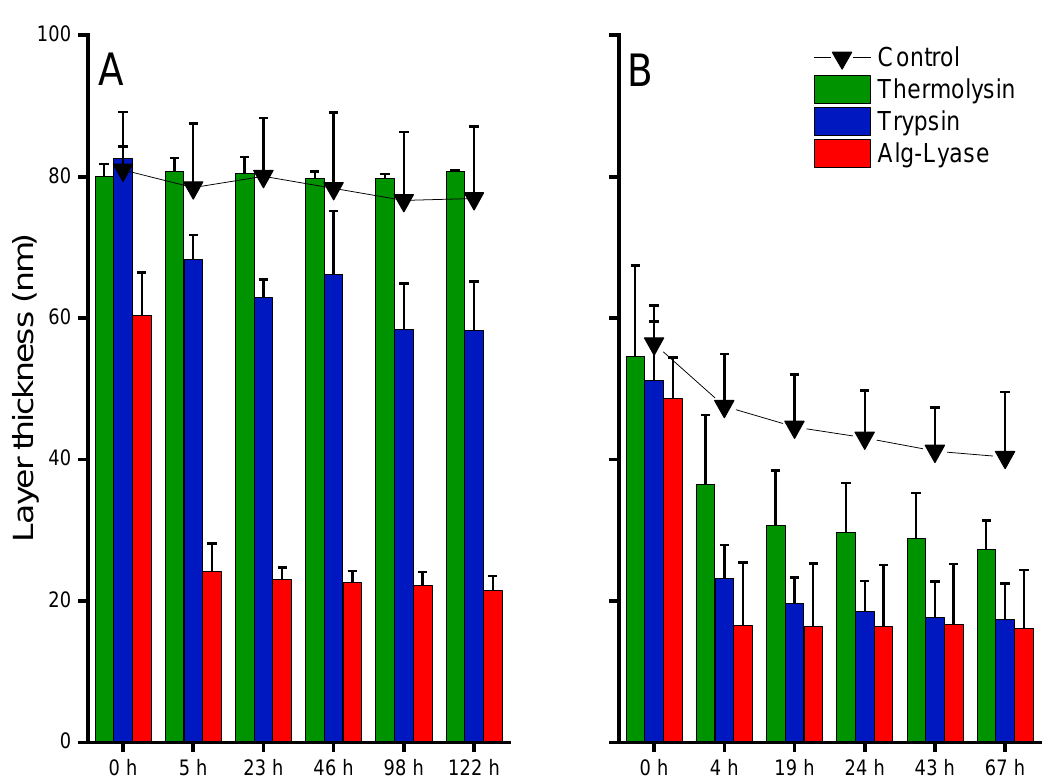
Figure 5. Monitoring ellipsometric layer thicknesses of ( A ) Alg/PLL and ( B ) Alg/NITEGE coatings while coincubated with control, thermolysin, trypsin, and alginate-lyase (each 2.5 µg/mL). n = 3.